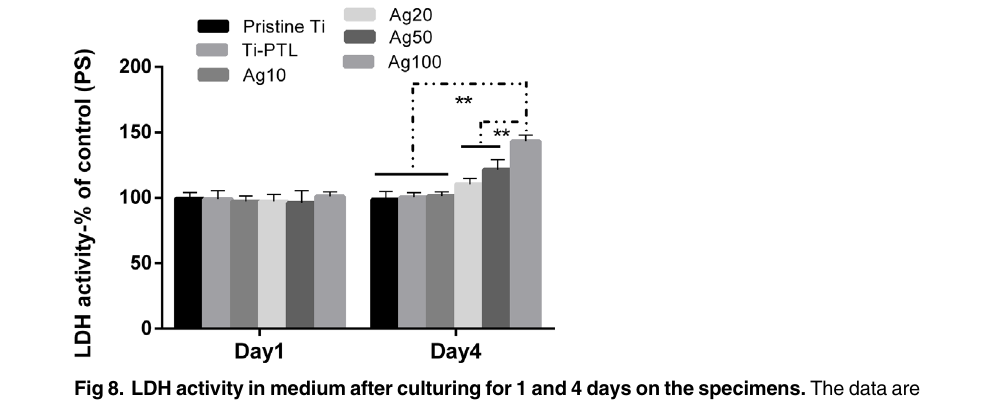
to determine the level of significance. * p < 0.05 and ** p < 0.01.